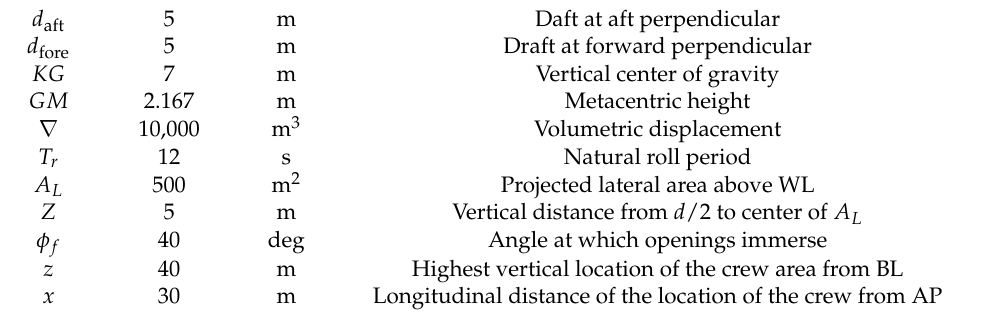
Table 4. Loading condition of